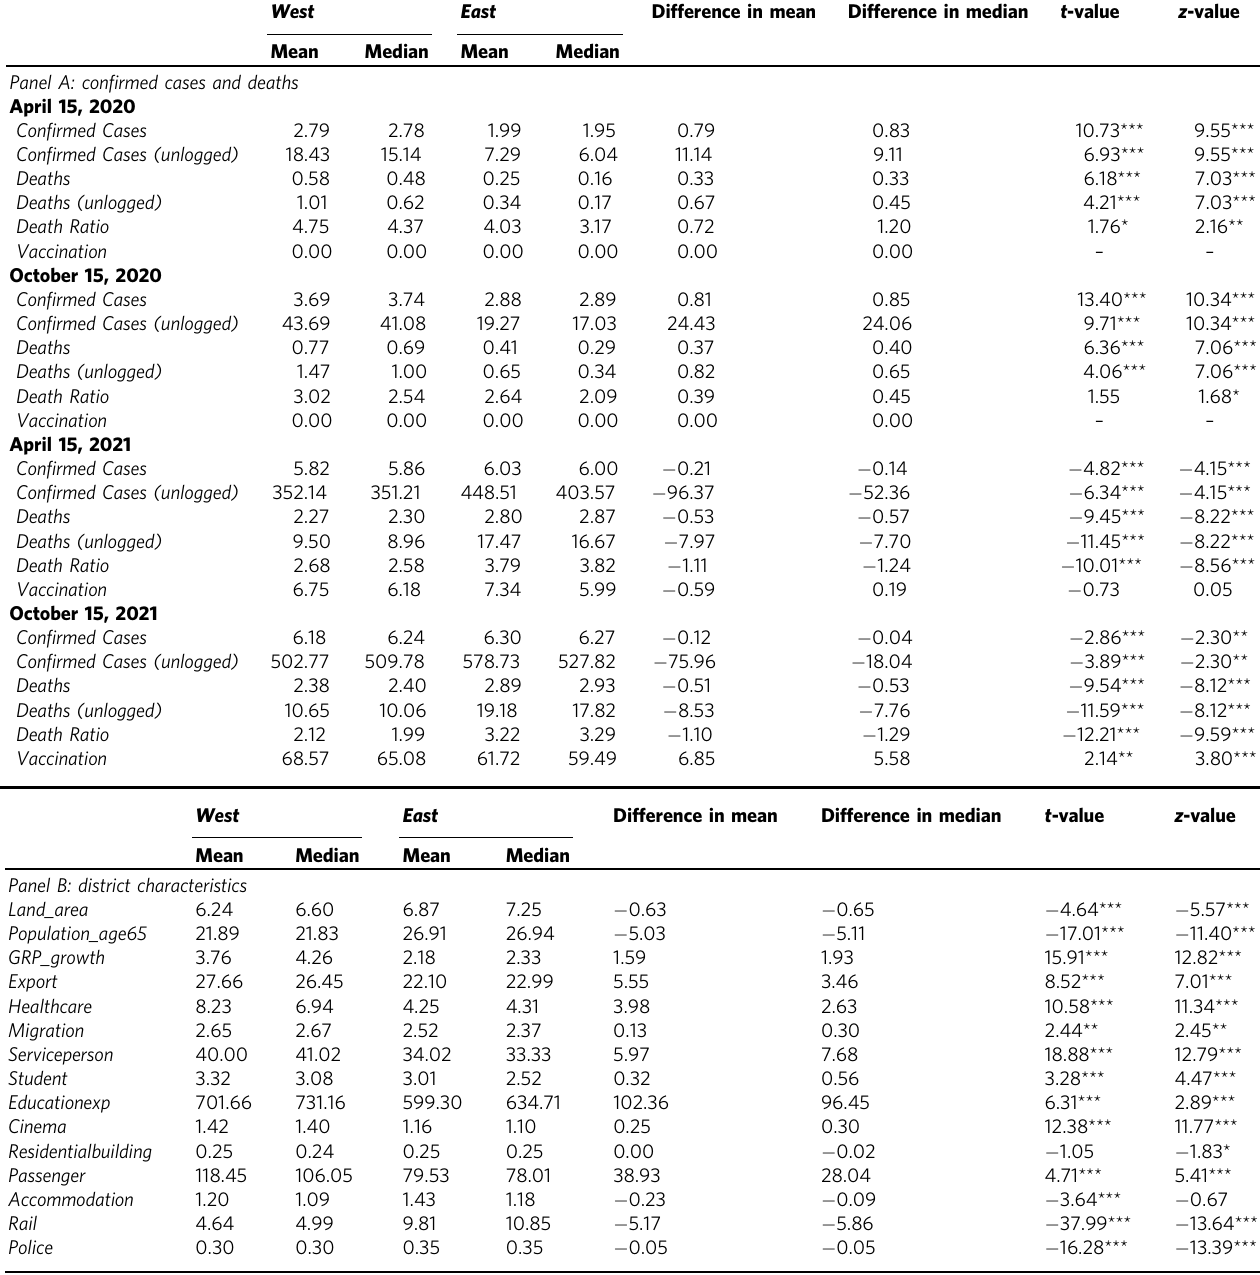
Table 3 Differences in major variable values between former east and west german districts. West East Difference in